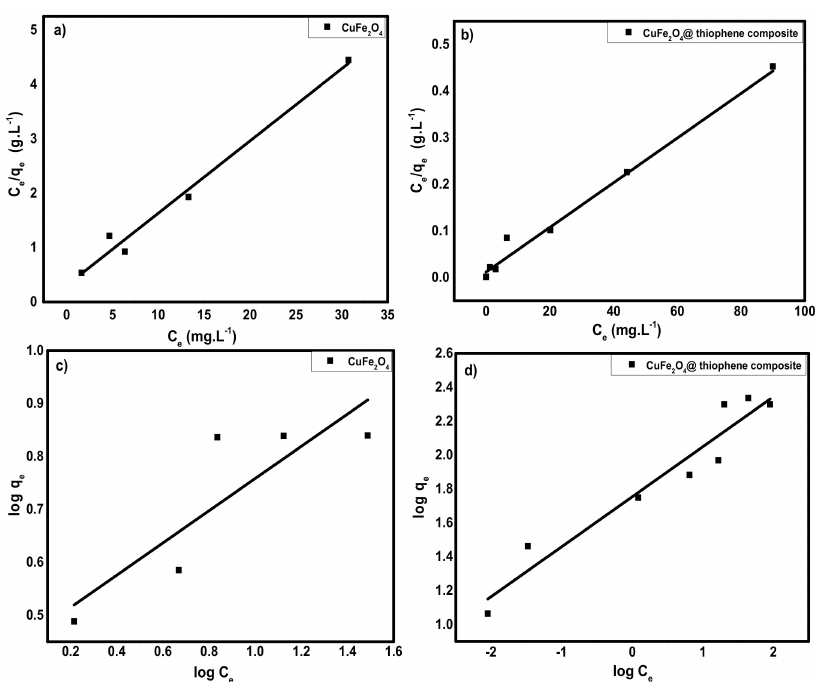
Figure 12. ( a , b ) Langmuir adsorption isotherm for adsorption of Hg(II) ions onto CuFe 2 O 4 and CuFe 2 O 4 @Polythiophene composite; respectively and ( c , d ) Freundlich adsorption isotherm for adsorption of Hg(II) ions onto CuFe 2 O 4 and CuFe 2 O 4 @Polythiophene composite; respectively.